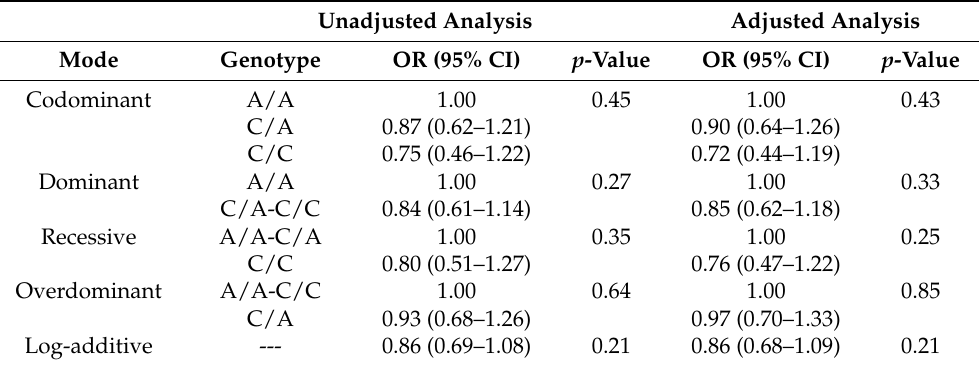
Table 4. Single locus analysis for association between CYP1A2 rs762551 and AD in codominant, dominant, recessive, overdominant, and log-additive modes. Unadjusted